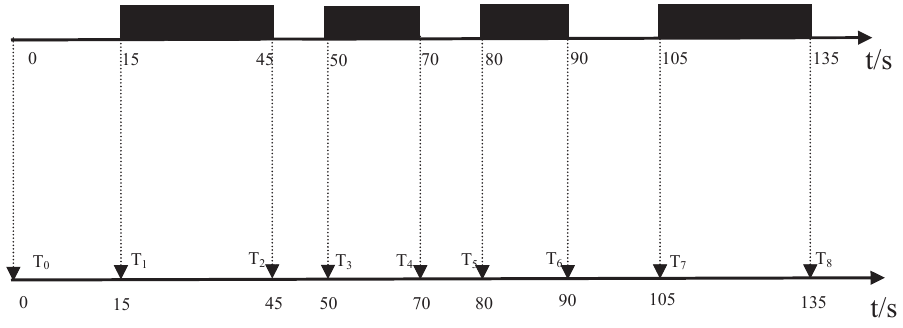
Figure 4. Operation on binary vehicle-detection time